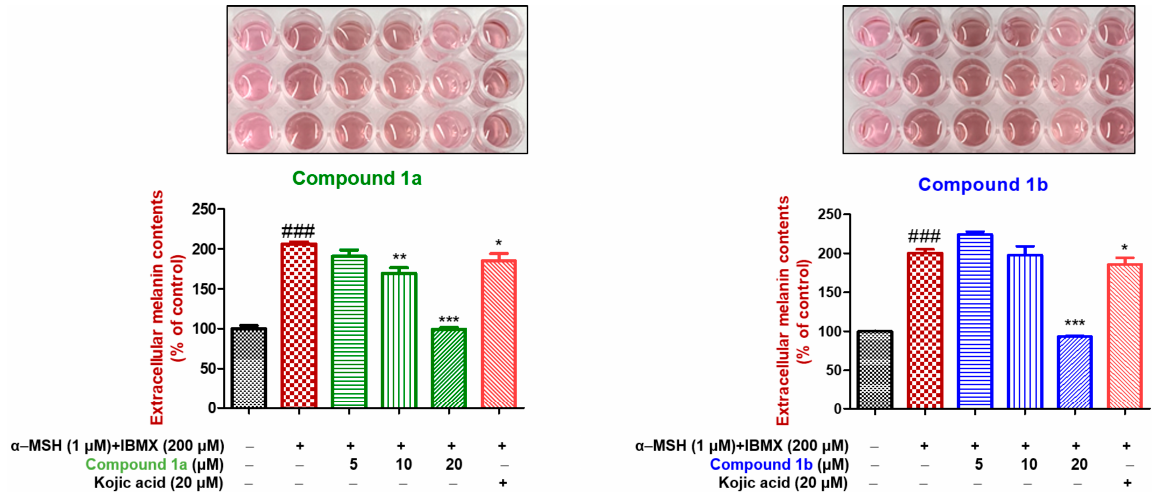
21 of 30 Figure 7. Effects of compounds 1a and 1b on B16F10 cell viability. Cell cytotoxicities were assessed using the EZ-Cytox assay after treating cells with 1a or 1b at 0, 1, 2, 5, 10, or 20 μ M for 48 h. Results are expressed as percentages of untreated controls, and bars represent standard errors. Experiments were conducted independently three times. 3.6. Inhibitory Effects of Compounds 1a and 1b on Extracellular Melanin Secretion by B16F10 Cells To investigate the inhibitory effects of 1a and 1b on melanin secretion into a medium, B16F10 cells were seeded in a 6-well culture plate and treated with 0, 5, 10, or 20 μ M of the test compounds. One hour after plating, 1 μ M of α -melanocyte-stimulating hormone ( α -MSH) and 200 μ M of 3-isobutyl-1-methylxanthine (IBMX) were added to increase ty- rosinase activity, and after incubation for 48 h, melanin contents in the media were calcu-